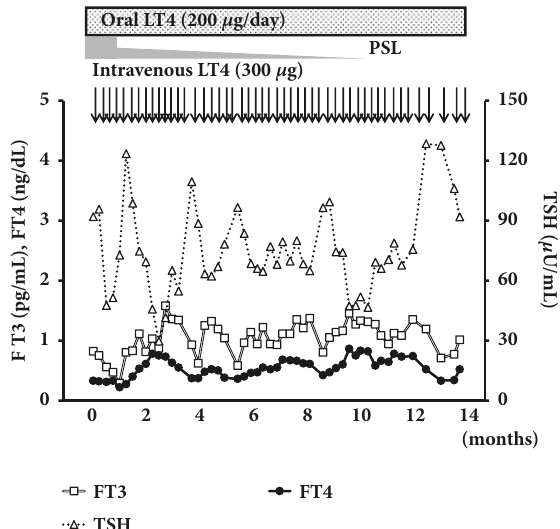
Figure 3: LT4 (300 𝜇 g) intravenous administration once in a week and two weeks . A daily oral LT4 (200 𝜇 g/day) replacement was continued. PSL (20 mg/day) was also orally administered at the onset of the weekly intravenous administration of LT4 (300 𝜇 g).